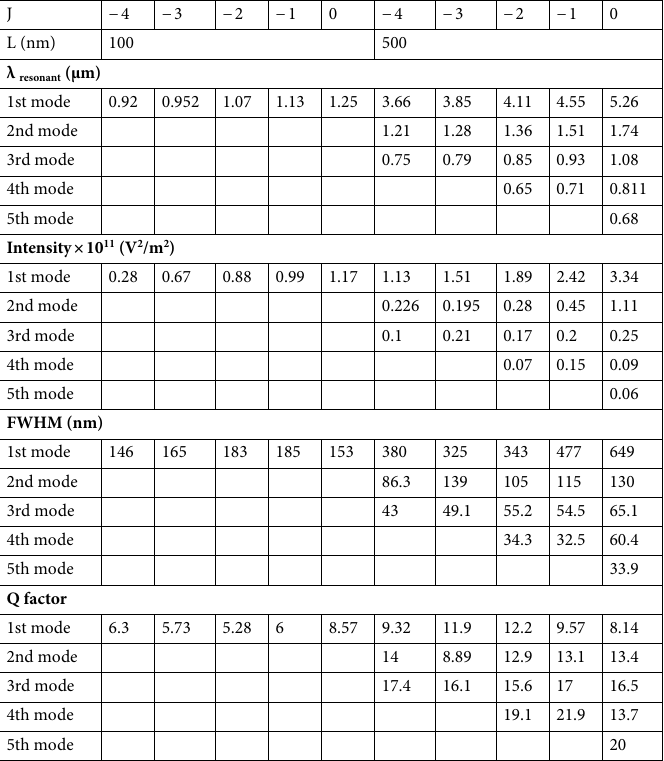
Table 2. Resonance wavelength, intensity, FWHM, and effective Q factor for a non-symmetric graded grating with w = 10 nm , Δ = 5 nm, d = 300 nm, n = 5. Note that increasing the groove depth from 100 to 500 nm increases the range of the localized wavelength across a larger spectral range extending from the visible to the